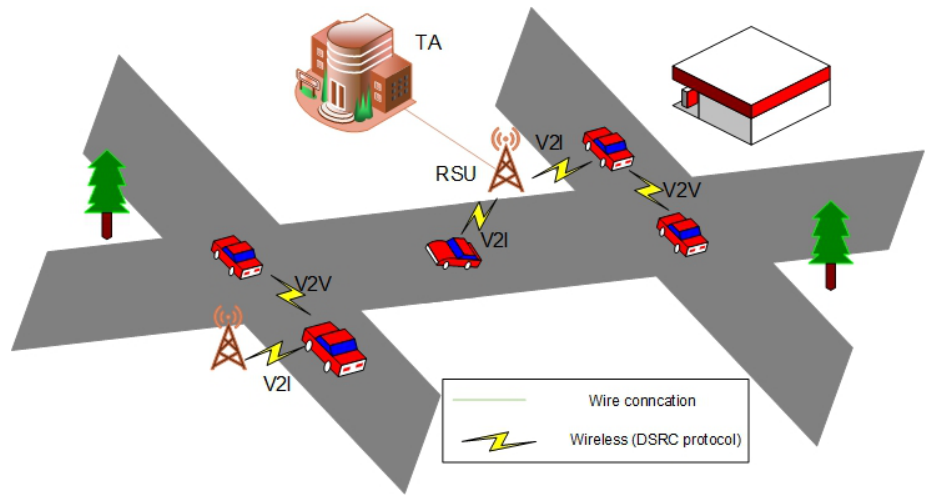
Figure 1. The main structure of the